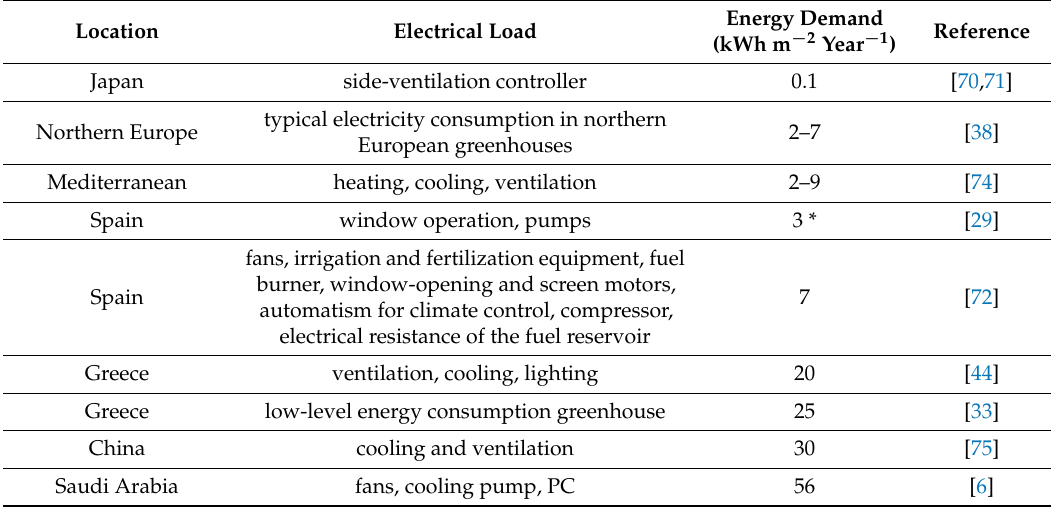
Table 4. Annual electrical energy demand per unit greenhouse area at different locations with various electrical